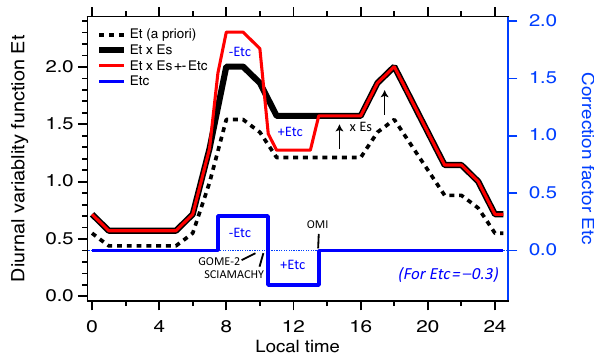
Figure 1. Schematic diagram of the correction scheme for the emis- sion diurnal variation for a case with Etc =− 0.3. The black dotted time represents the a priori emission diurnal variability function (Et) for anthropogenic emissions. The black solid line represents the a posteriori emission variation after applying the daily emission scal- ing factor (Et × Es). The blue line represents the correction factor for the emission diurnal variability (Etc). The red line represents the a posteriori emission variation after applying the daily emis- sion scaling factor and the correction factor for the emission diurnal variability (Et × Es − Etc for 07:30–10:30LT and Et × Es + Etc for